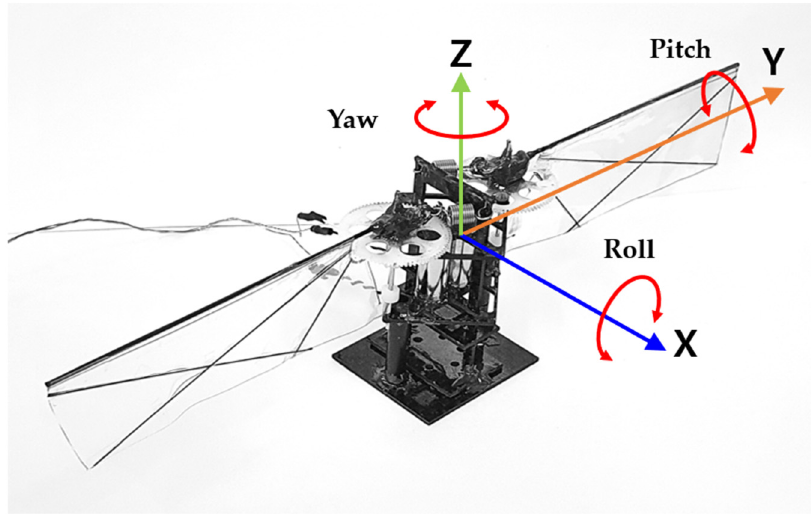
Figure 6. Prototype of the flapping winged flying robot with extension springs and the body frame coordinate definition. coordinate definition. Table 1. Weight of each